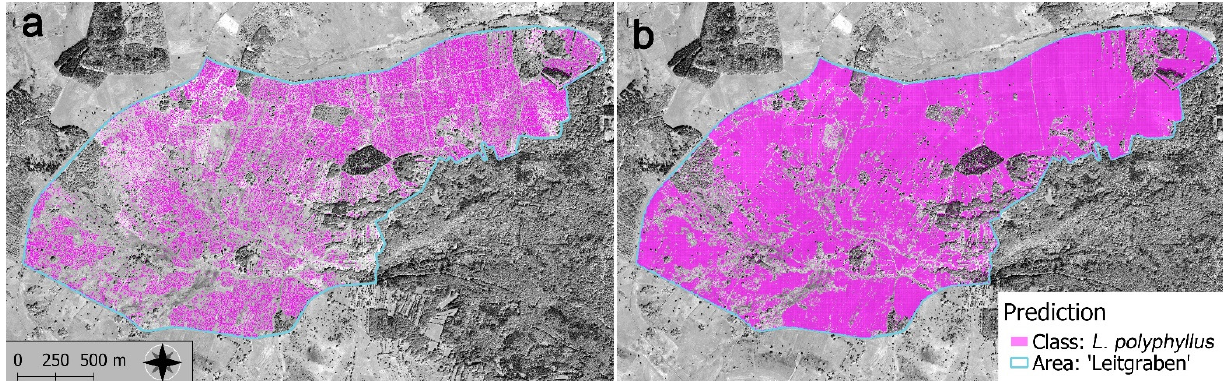
Figure 9. Prediction map from the area ‘Leitgraben’ predicted by GBM with tuning parameters from the leader GBM model (Table A3). The threshold for class distribution was set to the maximum value of ( a ) F0.5-score and ( b ) F2-score.